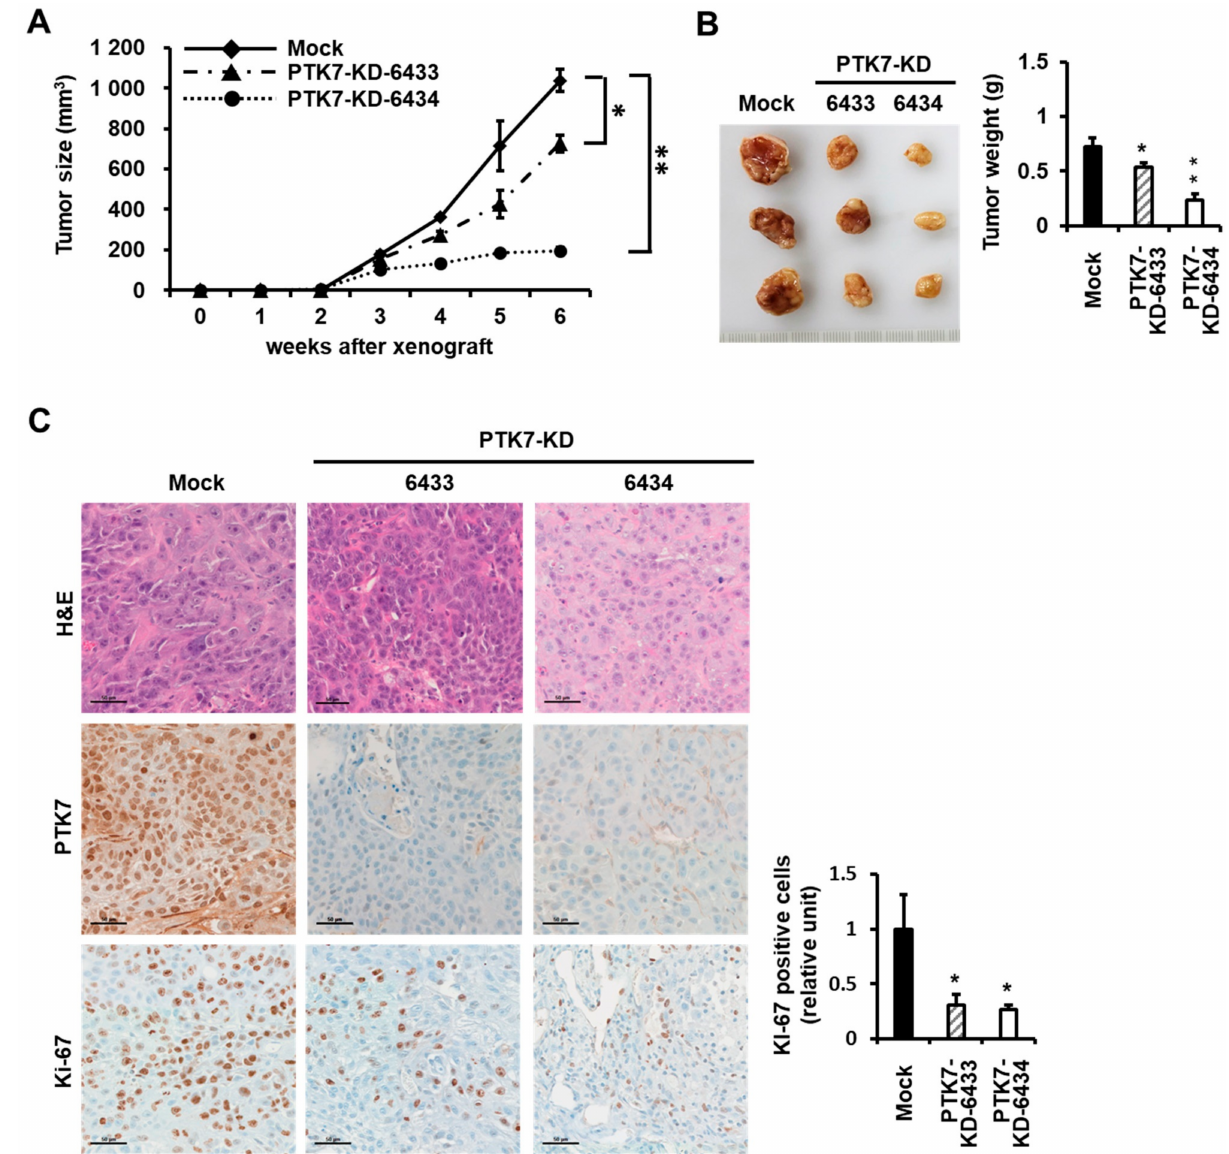
Figure 5. Effect of PTK7 knockdown on tumor growth in xenograft mice. KYSE-30 cells with mock- transfected or PTK7 knockdown (PTK7-KD-6433 and -6434) were subcutaneously xenografted into the dorsal regions of mice. ( A ) Tumor volumes were recorded for 6 weeks. ( B ) Images of tumors from mice at 6 weeks after injection (left) and the corresponding weights (right) are shown. Each bar represents the mean ± SD of the three mice. * p < 0.05, ** p < 0.01 vs. mock-transfected cells. ( C ) Representative images of histologic and immunohistochemical (PTK7 and Ki-67) analysis of tumors are shown in the indicated groups of mice. Scale bar represents 50 µ